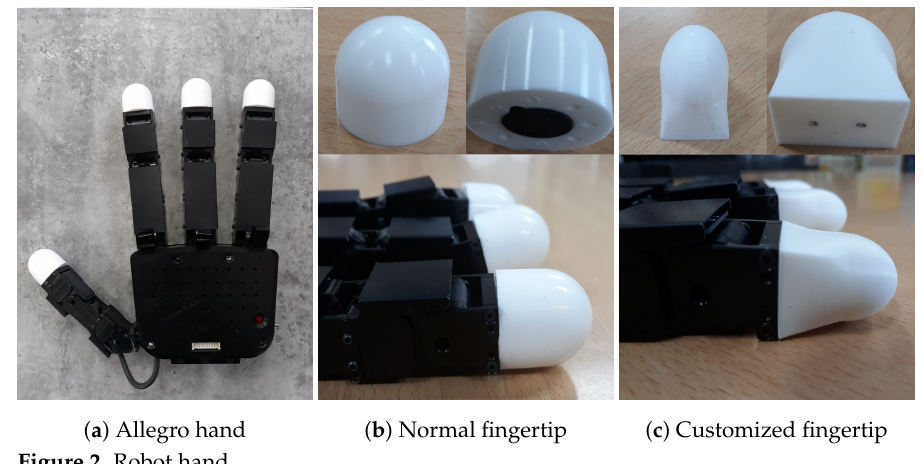
Figure 2. Robot hand.